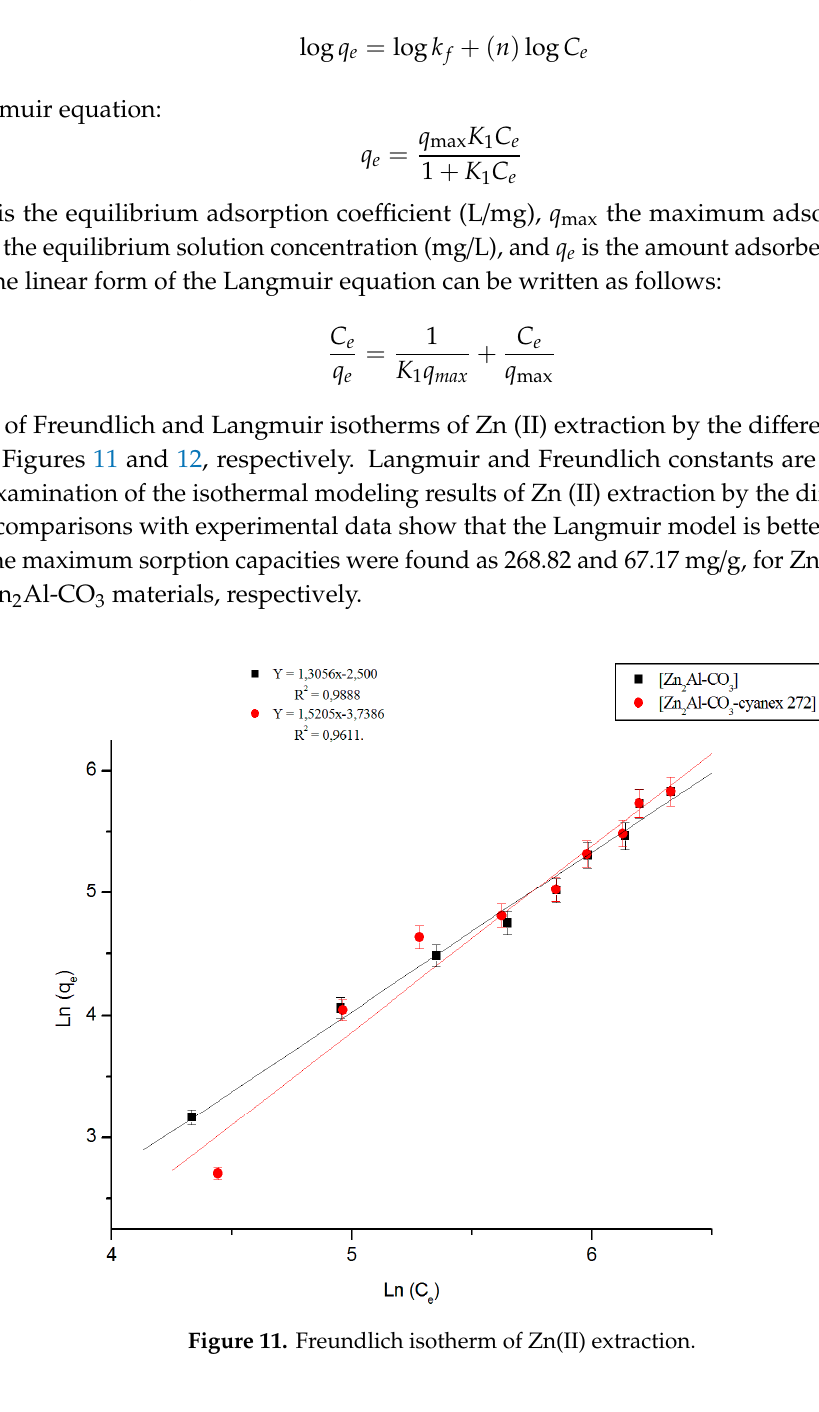
Figure 12. Langmuir isotherm of Zn(II) extraction. 4. Conclusions In this work, the lamellar-double-hydroxide materials impregnated with cyanex 272 were demonstrated to be promising for zinc removal from wastewaters. The experimental results allowed verifying three important issues: 1. The interlayer spacing increases after impregnation of solids, which is relevant for understanding the removal mechanism of metal ions from aqueous effluents.